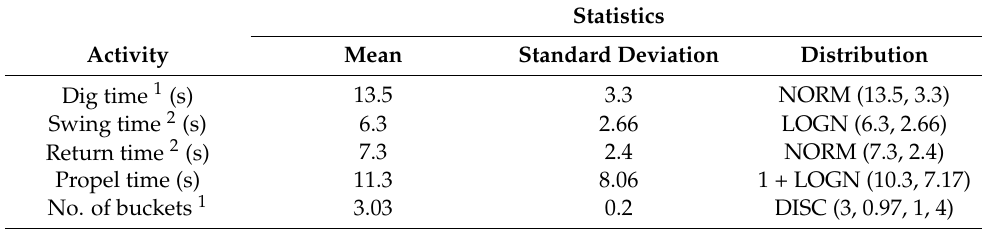
Table 4. Best operators loading statistics.